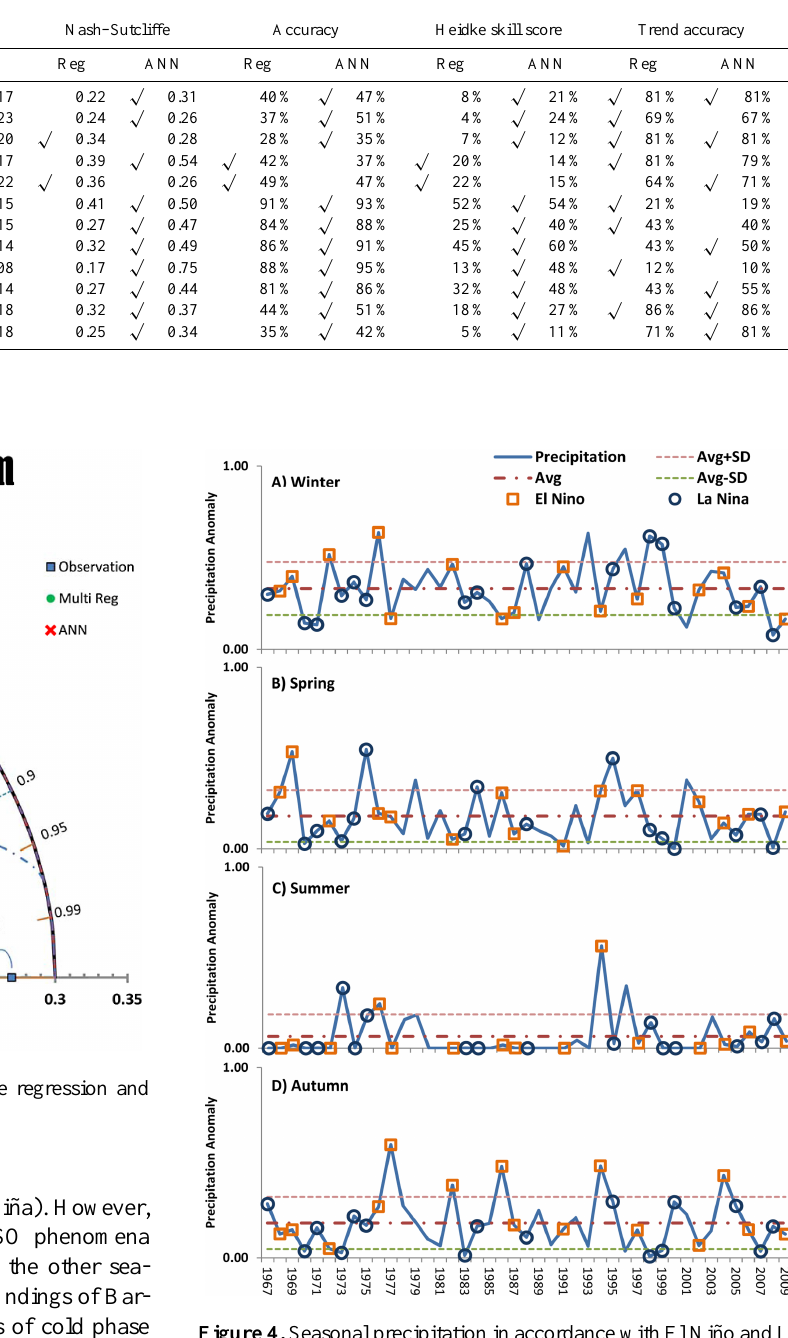
Figure 4. Seasonal precipitation in accordance with El Niño and La Niña